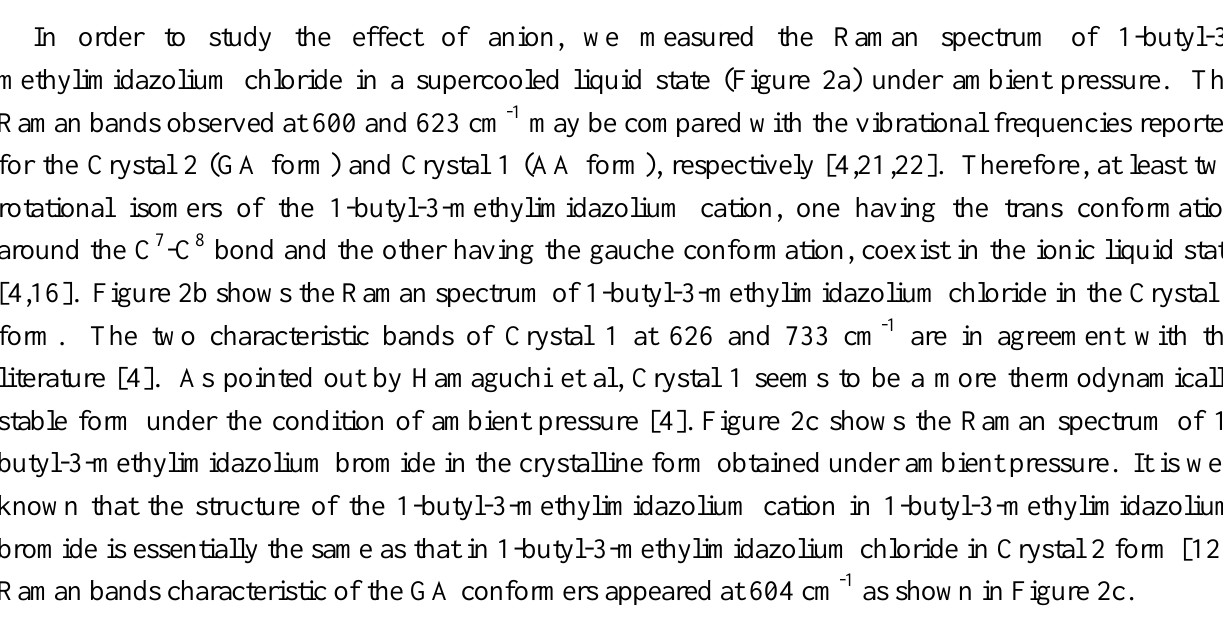
Figure 1. Numbering of the skeleton atoms for the 1-butyl-3-methylimidazolium